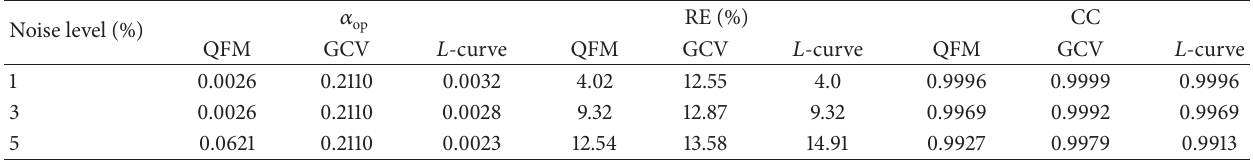
Table 3: Relative results of identified sine load of SISO system.